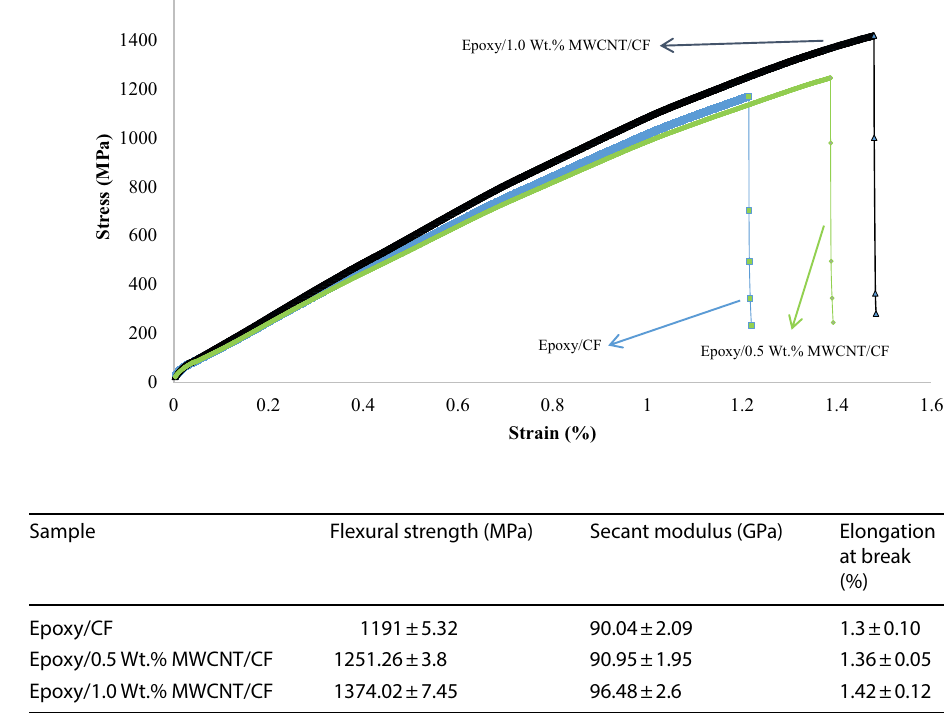
Table 2 The flexural strength, secant modulus, and elongation at break of composites achieved from three-point bending